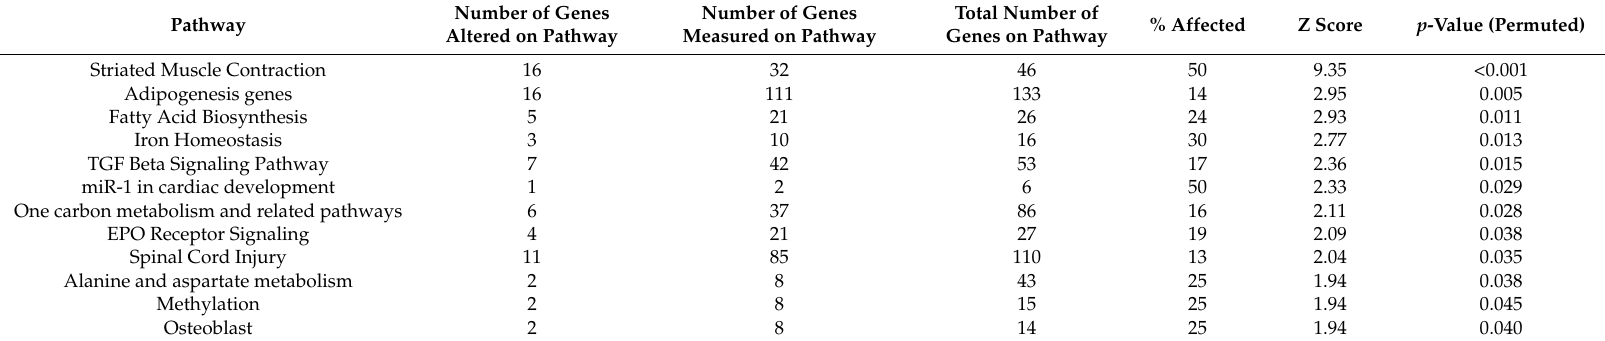
Table 3. WikiPathways in the fetal liver altered by maternal folate depletion during pregnancy 1,2 and identified using PathVisio. Number of Genes Number of Genes Total Number of Pathway % Affected Z Score p -Value (Permuted) Altered on Pathway Measured on Pathway Genes on Pathway Striated Muscle Contraction 16 32